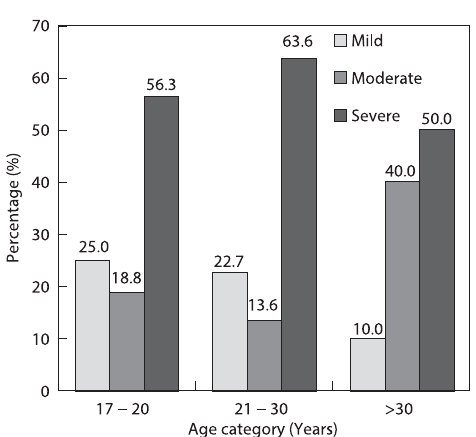
Figure 5: Distribution of adults diagnosed with acute hepatitis A by age group and grade